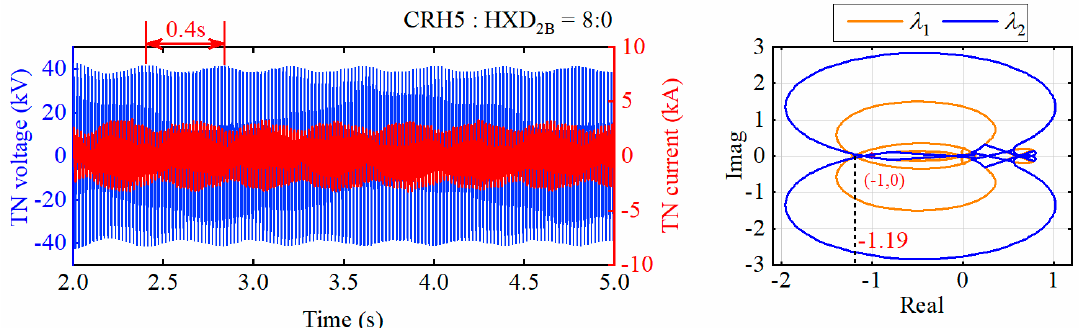
Figure 9. Simulation waveforms when the proportion of passenger and freight locomotives is changed.